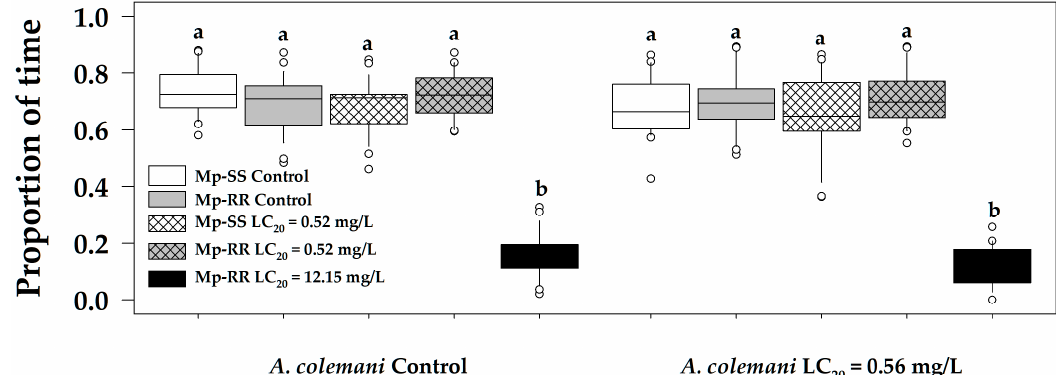
Figure 2. Proportion of time spent on each arm of the olfactometer in individuals of the parasitoid wasp Aphidius colemani exposed and unexposed to LC 20 of the insecticide lambda-cyhalothrin (Zero 5 EC). Using a 4-arm olfactometer, parasitoid individuals were offered with kdr -susceptible (Mp-SS) and kdr -resistant (Mp-RR:) M. persicae aphids exposed (LC 20 ) and unexposed (water as control) to lambda-cyhalothrin. Mp-SS exposed to LC 20 of kdr-resistant aphids are not shown, as all aphids were dead. Two arms of the olfactometer were connected to glass bottles containing pepper plants with aphids, while the other two arms were connected to glass bottles containing only pepper plants (no aphids). Different letters indicate significant differences (Tukey multiple comparisons test, p < 0.05).